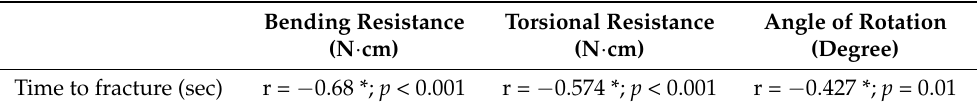
Table 3. Correlation of the time to fracture (TTF) with bending, torsional resistance and angle of rotation of the tested NiTi files. Bending Resistance Torsional Resistance Angle of Rotation (N · cm) (N · cm) (Degree) Time to fracture